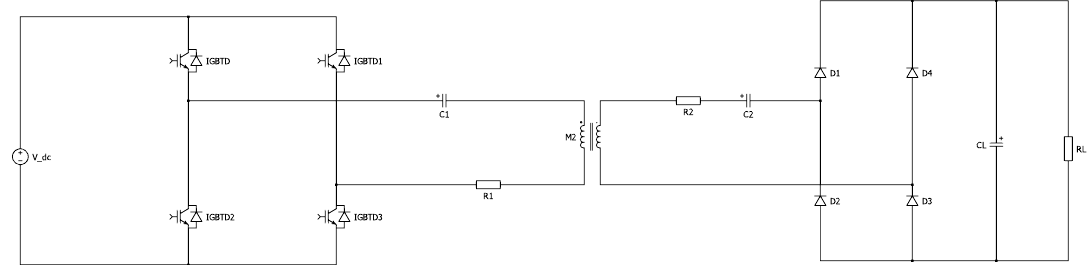
Figure 4. Circuit scheme of the inductive power transfer system which includes an inverter for the primary coil and a rectifier for the secondary coil.